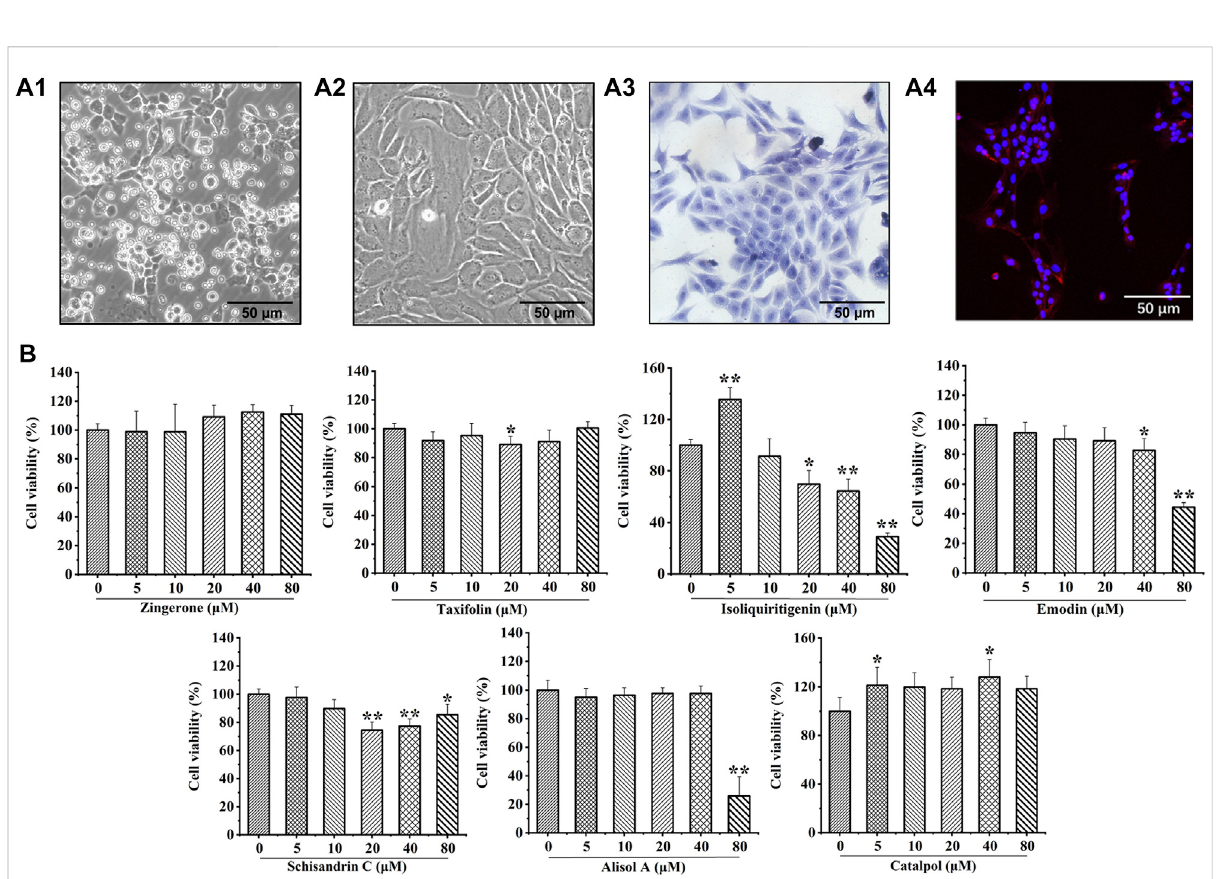
FIGURE 3 Culture and identi fi cation of rat chondrocytes, and the effects of seven potential active constituents (Isoliquiritigenin, Emodin, Taxifolin, Catalpol, Alisol A, Zingerone, and Schisandrin C) on rat chondrocytes viability. (A1) Primary rat chondrocytes cultured for 24 h; (A2) Primary rat chondrocytes cultured for 7 days; (A3) Toluidine blue staining of primary rat chondrocytes; (A4) Immuno fl uorescence staining of collagen II of primary rat chondrocytes; (B) Effect of seven potential active constituents (Isoliquiritigenin, Emodin, Taxifolin, Catalpol, Alisol A, Zingerone,and Schisandrin C) on chondrocytes viability at different concentrations (0, 5, 10, 20, 40, and 80 μ M) for 24 h. * p < 0.05, ** p < 0.01 compared with the control